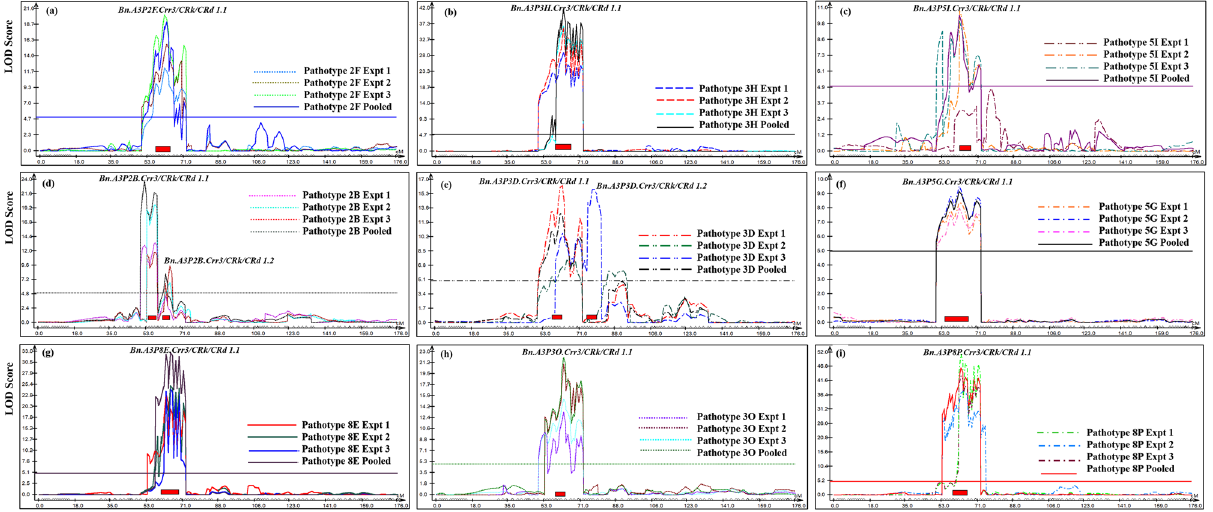
Figure 2. QTL likelihood profile of the A03 chromosome of Brassica napus obtained by use of both ‘Mendelian’ and low ‘distorted’ markers. The peak regions indicate genomic regions conferring resistance to nine Plasmodiophora brassicae pathotypes, 2F ( a ), 3H ( b ), 5I ( c ), 2B ( d ), 3D ( e ), 5G ( f ), 8E ( g ), 3O ( h ) and 8P ( i ). Clubroot resistance in the DH lines was derived from the Brassica napus cv. ‘Tosca’. The LOD scores are indicated on the y-axis and the QTL names positioned at the peak of each